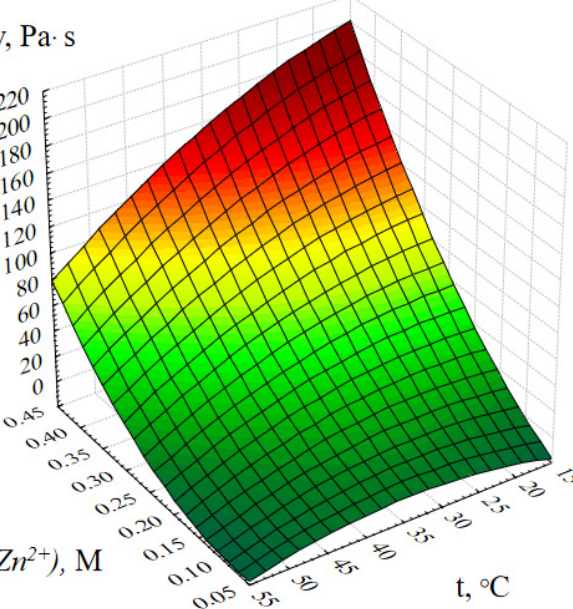
Figure 1. Response surface of the output parameter Y v (dynamic viscosity of the ZnO gel) depending on the concentration of zinc acetate and the temperature of the reaction medium.